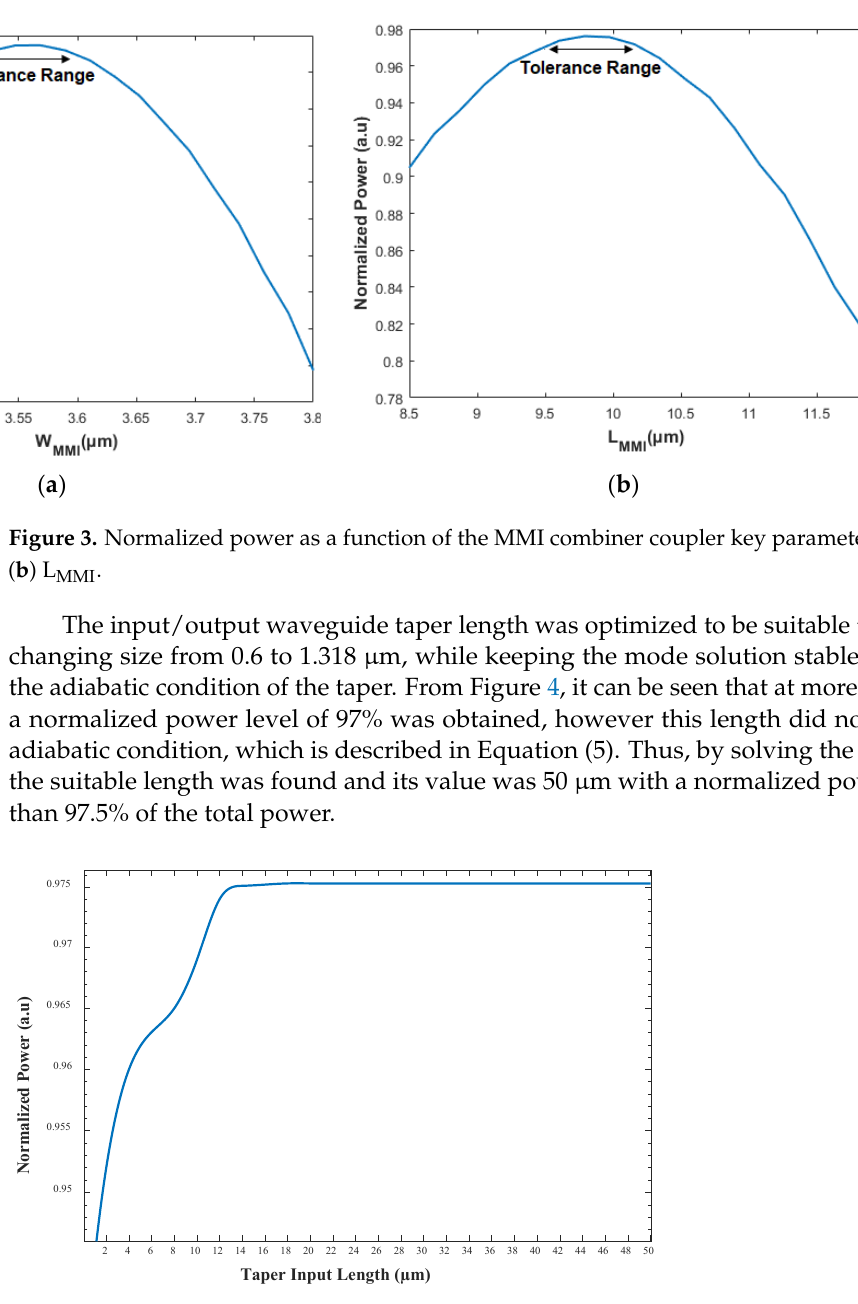
Figure 4. Optimizations of the waveguide taper length.